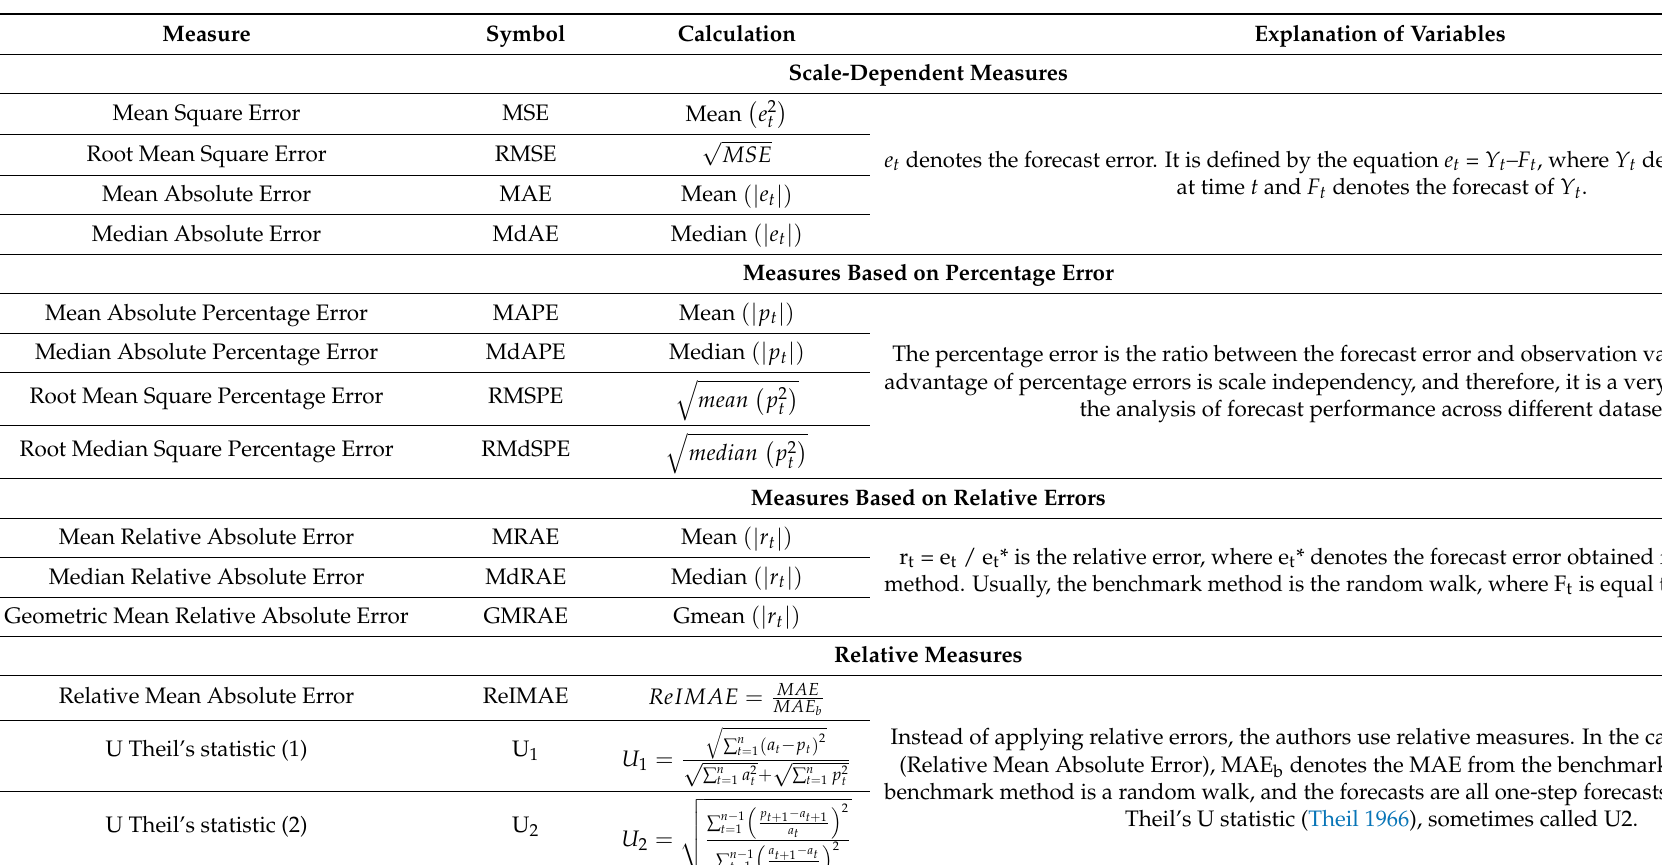
Table 6. Classification of traditional measures of economic forecast